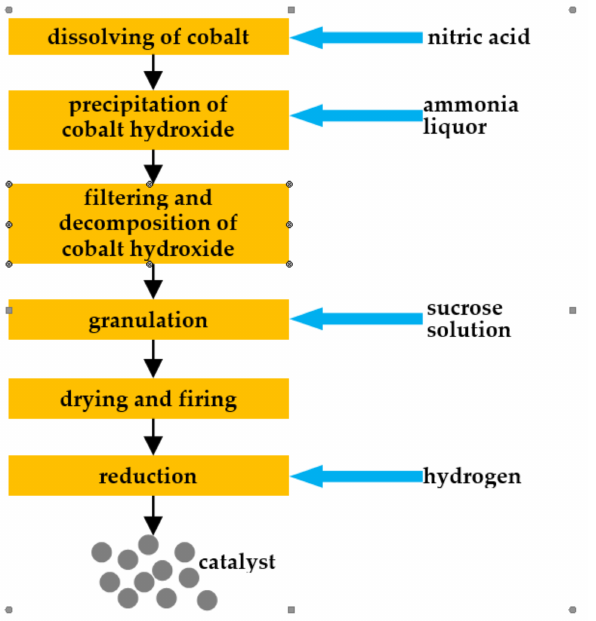
Figure 9. Schematic illustration of the cobalt catalyst preparation